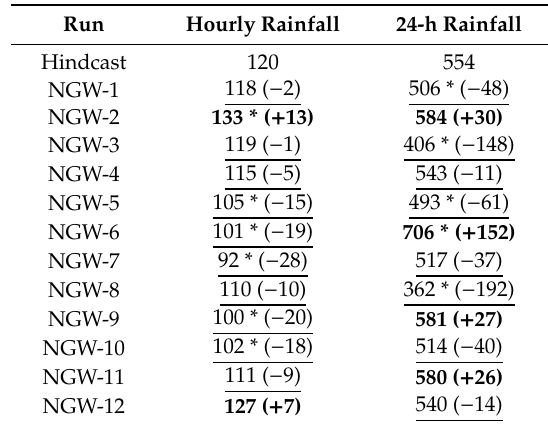
Figure 9. Probability density curves of the mean total rainfall for area A (R T,A ). The horizontal axis is R T,3 (mm). The vertical axis is the probability density. Table 7. Ensemble mean values of the maximum hourly and 24-h